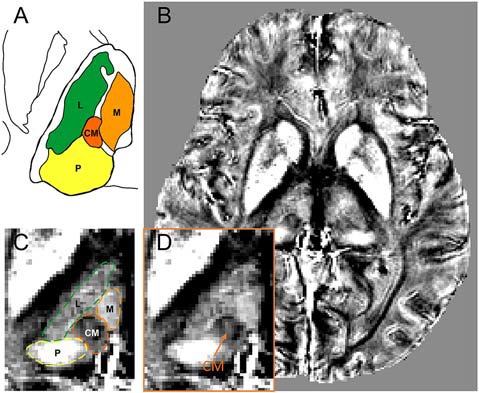
The visualization of CM within the thalamus on quantitative susceptibility mapping (QSM) image. (A) A schematic drawing of the CM and its surrounding thalamic structures, referenced to the overlay of the Schaltenbrand and Wahren atlas (Schaltenbrand et al., 1977). (B) An axial view of a slice of QSM image with thalamic substructures on a representative patient. (C) Enlarged view of thalamic substructures with the anatomical boundaries of CM and its surrounding thalamic parts (medial, lateral, and posterior) delineated. (D) Enlarged view of thalamic substructures. The anatomical location of CM nucleus is pointed by an orange arrow. Abbreviations: CM, centromedian nucleus. L, lateral part of thalamus; M, medial part of thalamus; P, posterior part of thalamus.